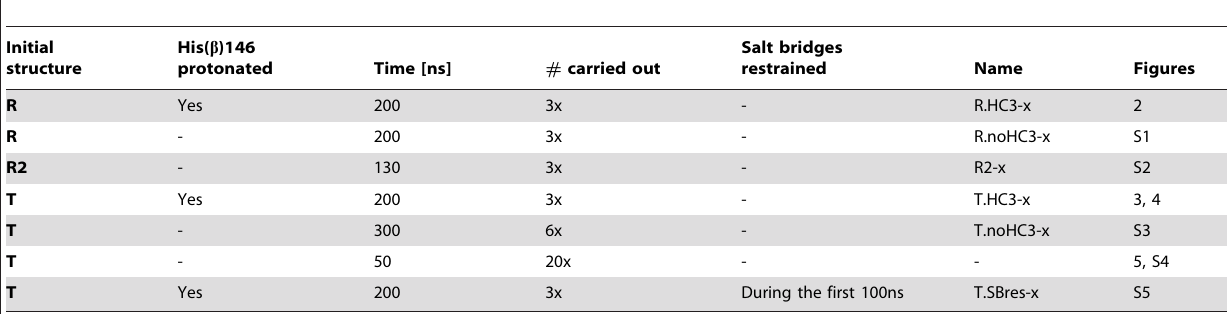
Table 1. Summary of molecular dynamics simulations of human hemoglobin A carried out for the present study.